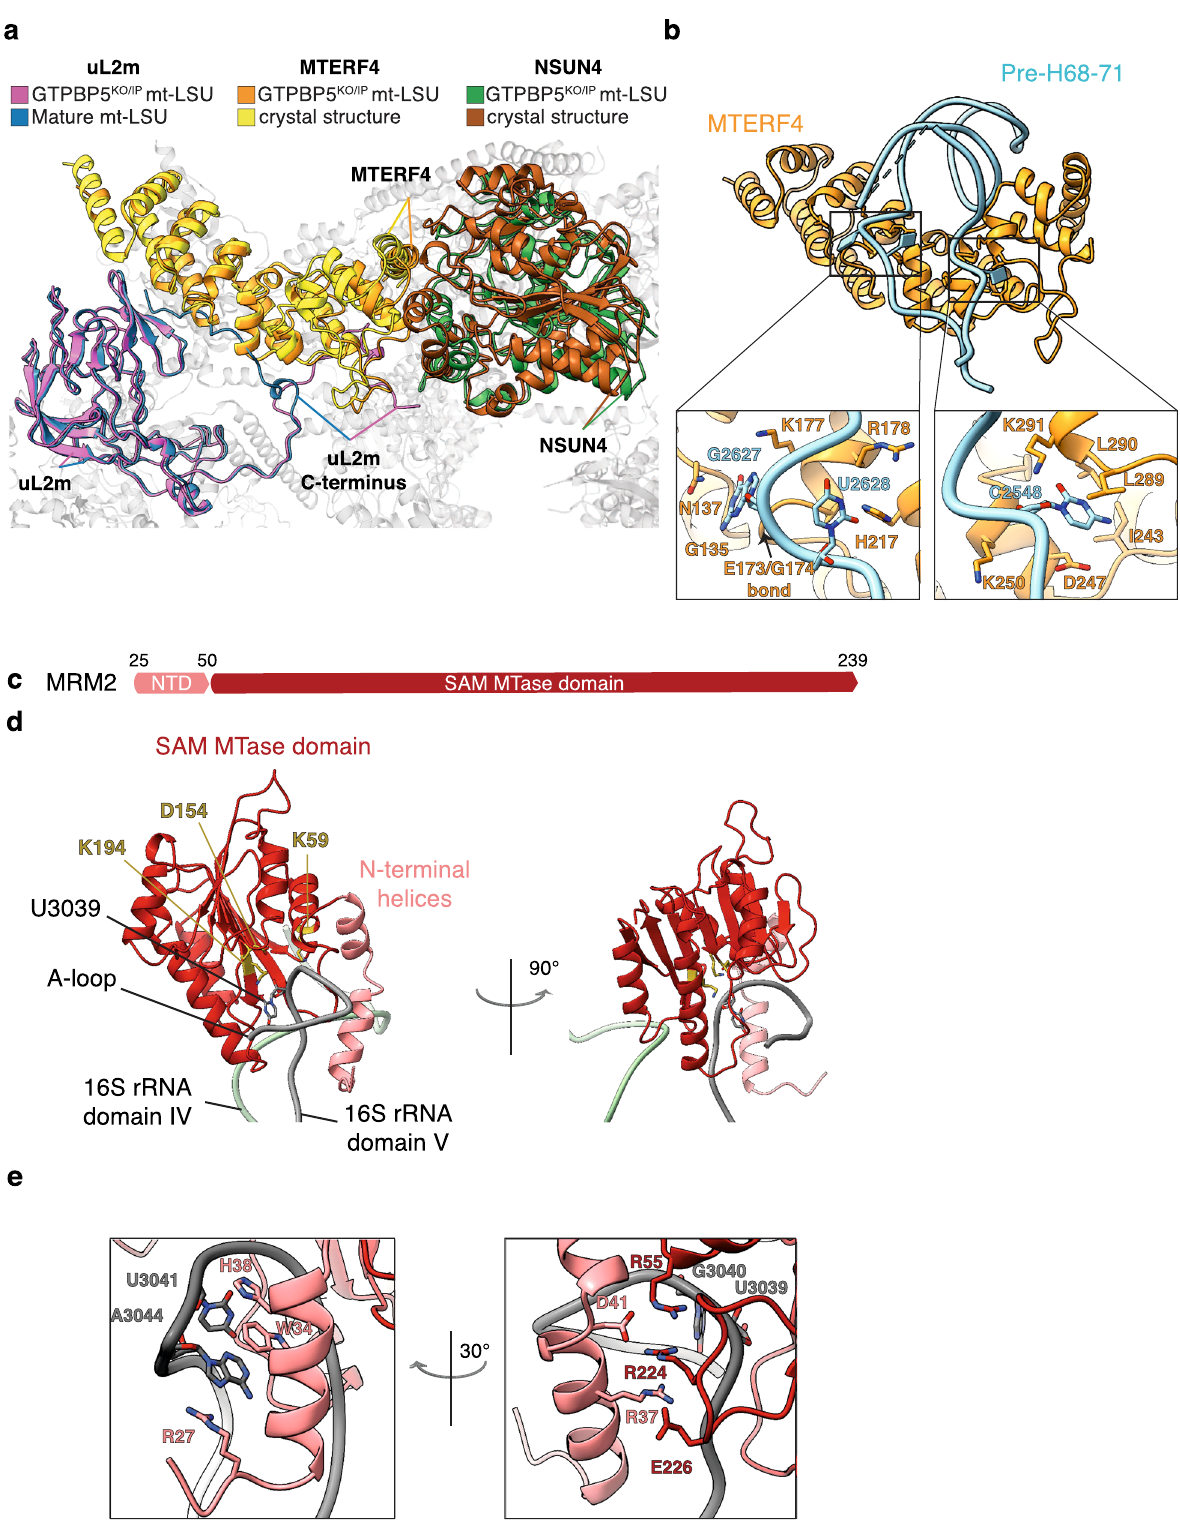
Fig. 2 MTERF4 – NSUN4 and MRM2 interaction with the mt-LSU assembly intermediates. a Comparison of the MTERF4 – NSUN4 complex bound to the GTPBP5 KO/IP mt-LSU (orange and green, respectively) with the MTERF4 – NSUN4 crystal structure (PDB: 4FP9 6 ) (yellow and brown, respectively), and of uL2m from the GTPBP5 KO/IP mt-LSU (pink) with uL2m from the mature mt-LSU (blue) (PDB: 3J7Y 23 ). The uL2m C-terminus is indicated in both structures. Pre-H68-71 is not shown. b MTERF4 – NSUN4 complex bound to pre-H68-71. Zoom-in panels show the interactions of MTERF4 with the pre-H68-71. c Schematic representation of MRM2 domains (NTD — light pink, SAM MTase domain — red). d MRM2 interaction with the domain IV rRNA (nucleotides 2644 – 2652, green) and the A-loop (grey). The MRM2 methylation site (U3039), as well as the catalytic triad of MRM2 (K59, D154, and K194), are highlighted as sticks. e Zoom-in views showing MRM2 interactions with the A-loop in different orientations.